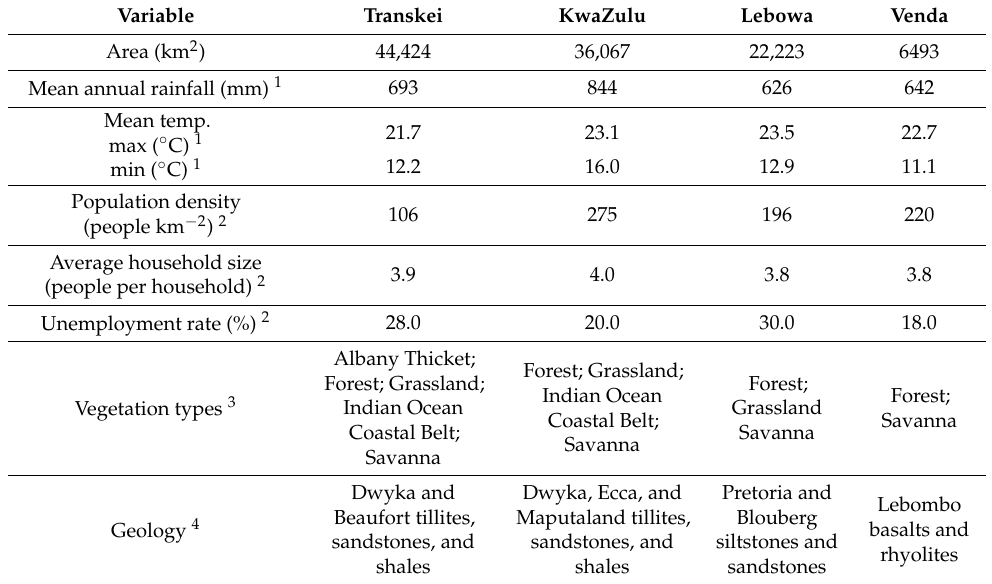
Table 1. Climate, demographic and land use information for Transkei, KwaZulu, Lebowa, and Venda. Variable